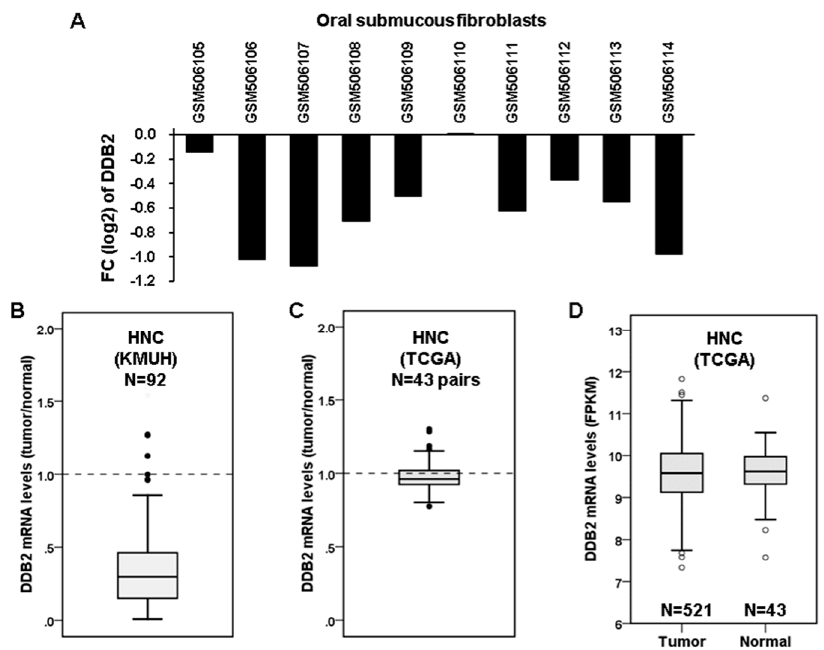
Figure 6. DDB2 is downregulated in oral submucous fibroblasts (OSFs) and head and neck cancer (HNC) specimens collected from betel quid (BQ)-epidemic areas. ( A ) The expression of DDB2 mRNA was downregulated in 8 out of 10 OSFs in the GSE20170 dataset. FC, fold-changed (OSFs versus